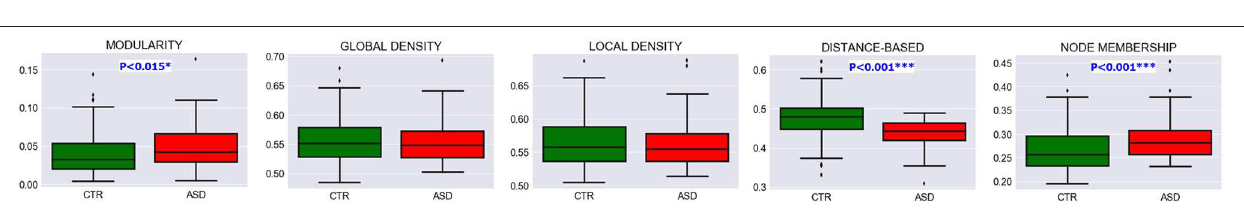
FIGURE 5 | Evidence of community pattern alteration in ASD. Box plots reveal group differences in terms of community quality indexes at T = 0.5 in pooled data across experimental sites . P -values were generated with the two-sample Kolmogorov-Smirnov test and subsequently FDR-corrected. recent autism classification studies, this study obtained a retrained the classifiers and performed a 10-fold cross-validation relatively high classification accuracy with the lowest number of test. Multisite data yielded peak accuracy at T = 0.5 predictors ( Table 6 (65.66% for KNN and 74.86% for LDA). Compared with